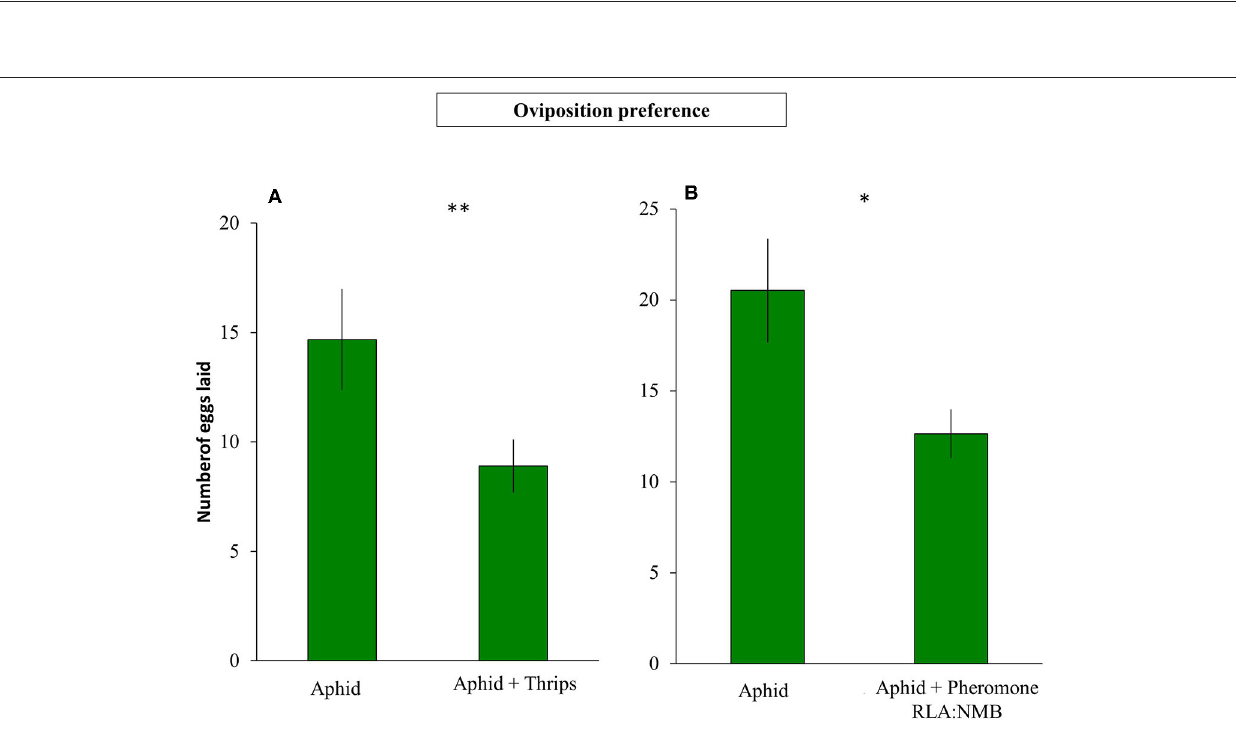
Frontiers in Ecology and Evolution |